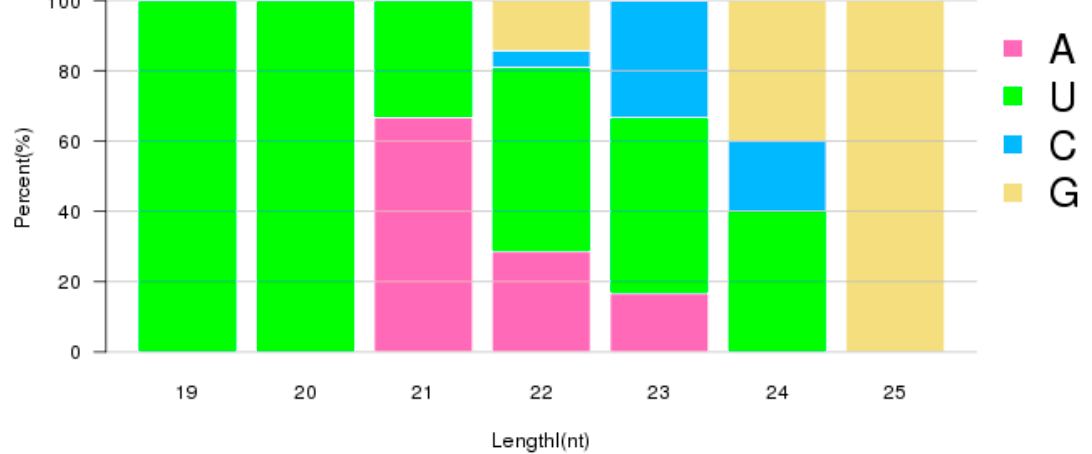
Figure 4. The percentage of the first nucleotide at the 5 ′ end of identified RKN miRNAs.